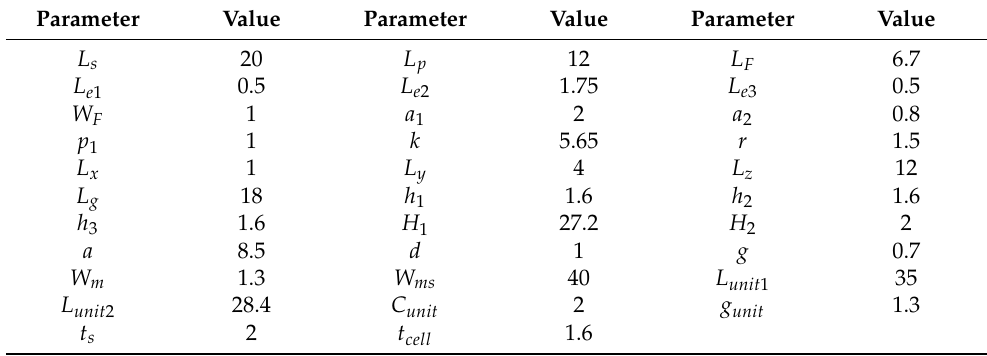
Figure 1. ( a ) Top view and ( b ) bottom view of the antenna; ( c ) top view of the AMC-MS reflector; and ( d ) side view of the antenna. Table 1. Dimensions of the proposed antenna configuration (unit: All are in